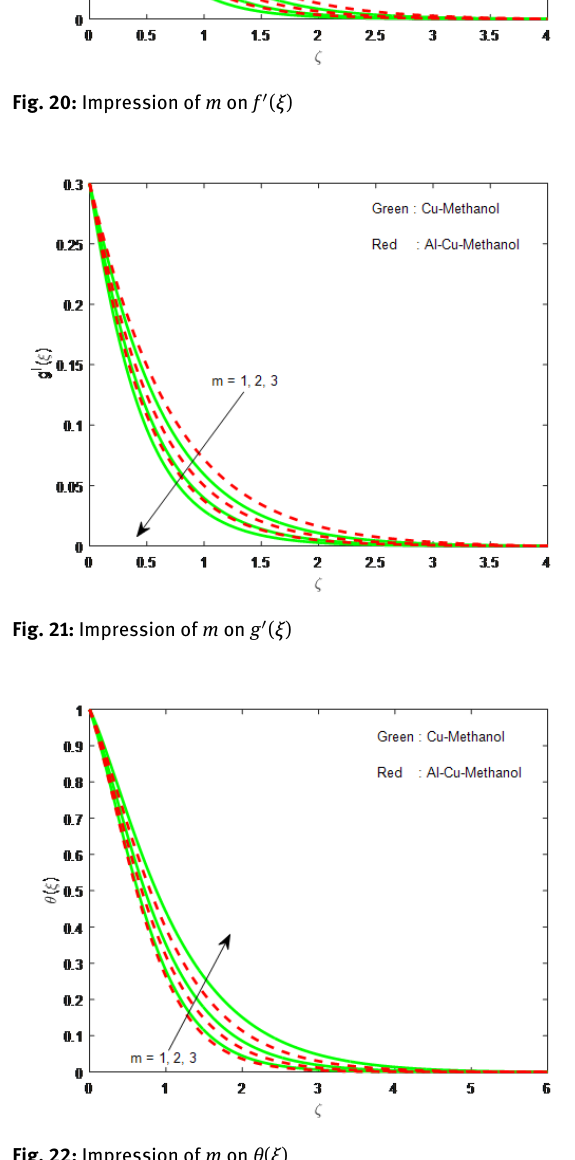
Fig. 22: Impression of m on θ ( ξ